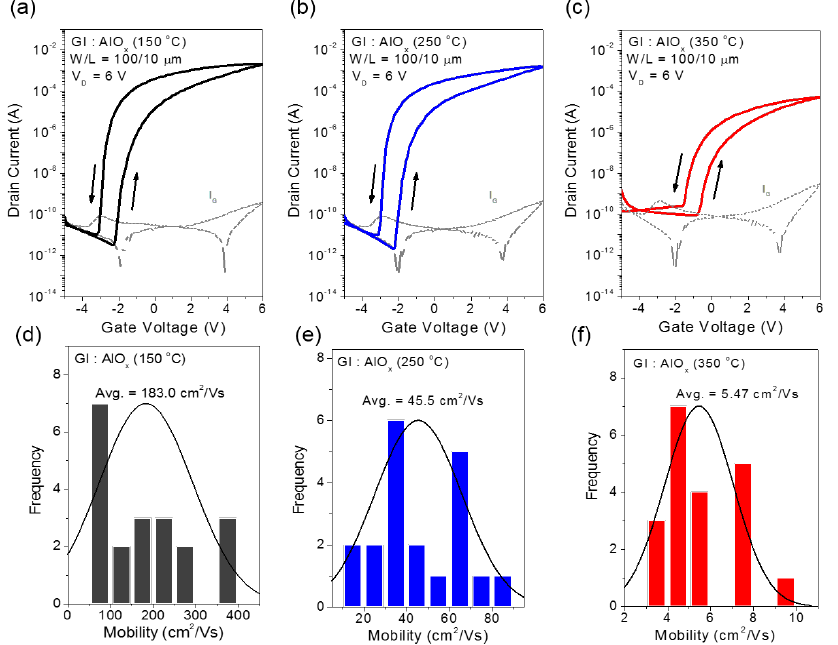
Figure 3. Electrical characteristics of various solution-processed InO x TFTs on an AlO x dielectric layer for the different processed conditions. The transfer curves for InO x TFTs with ( a ) 150 °C-annealed; ( b ) 250 °C-annealed; and ( c ) 350 °C-annealed AlO x films; the dotted lines indicate the gate leakage current. Statistical distribution of field-effect mobilities for InO x TFTs with ( d ) 150 °C-annealed; ( e ) 250 °C-annealed; and ( f ) 350 °C-annealed AlO x films.